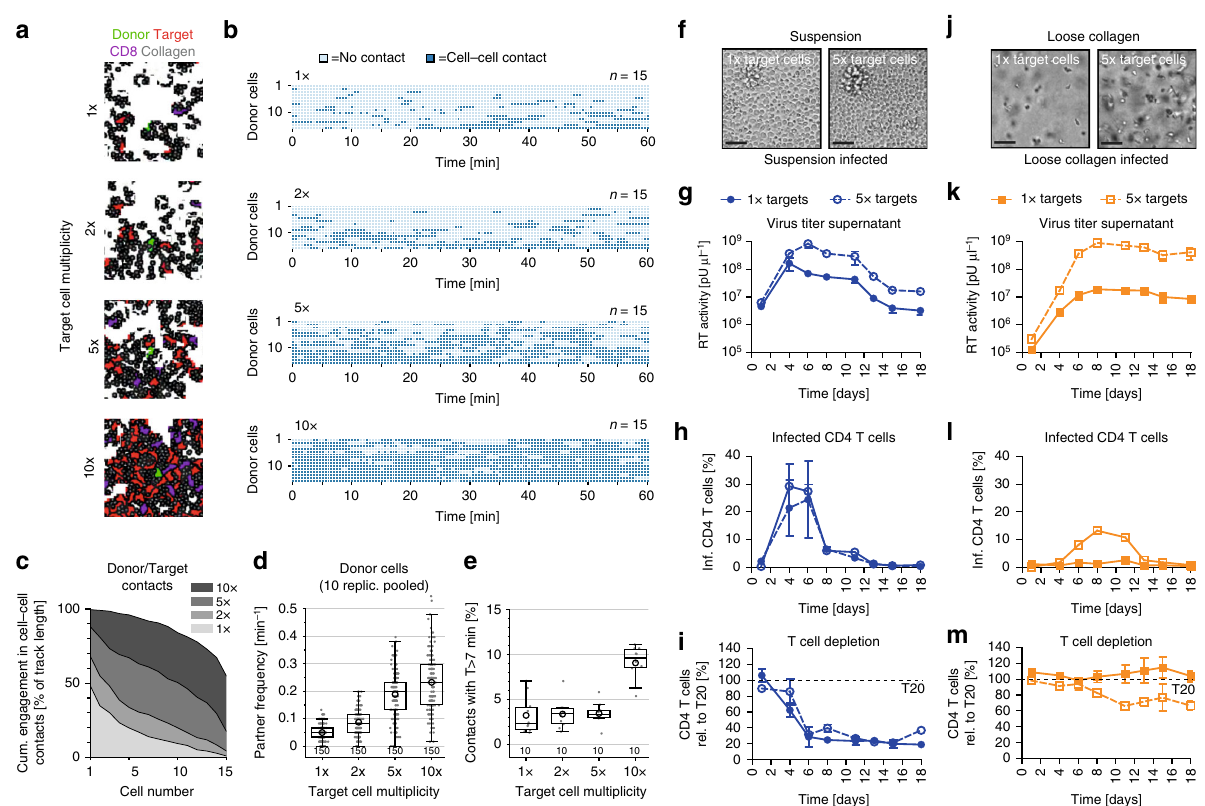
Fig. 7 Step 8: Experimental validation of model prediction shows dependency of HIV spread on target cell concentrations in loose collagen. a Snapshots of in silico spatial infection model simulations for loose collagen (gray) using a constant number of infected donor cells (green) mixed with varying concentrations (1× – 10×) of uninfected CD4 target cells (red) and CD8 cells (purple). b Contact diagram for simulated donor cells with target cells in loose collagen for varying target cell concentrations. Individual cell tracks are color coded: light blue, without contact, dark blue, in contact with another cell. One representative simulation of 10 replicates is shown. c Corresponding cumulative cell – cell contact durations of simulated donor cells from panel ( b ). d Partner frequency of individual HIV-1 infected donor cells pooled from 10 independent simulations with 15 cells each (150 cells total) followed over 1 h for each concentration of target cells. The graph shows boxplots with Tukey style whiskers, circles indicate mean values. e Proportion of long-lasting cell contacts (>7 min) between infected and target cells from 10 independent simulations. f – m Experimental data for comparison of the infection dynamics in suspension (blue, f – i ) and loose collagen (orange, j – m ) using the standard (1×, solid lines) and fi vefold increased (dashed lines) concentration of target cells. Scale bar of representative bright- fi eld images: 40 µ m. g , k Virus concentrations determined from supernatants by SG-PERT. h , l Percentage of infected (p24 + ) CD4 T cells determined by fl ow cytometry. i , m T cell depletion as residual CD4 T cells relative to respective T20 control, which was set to 100% (black dashed line). Mean and standard deviation from parallel triplicate infections of cells from the same donors are